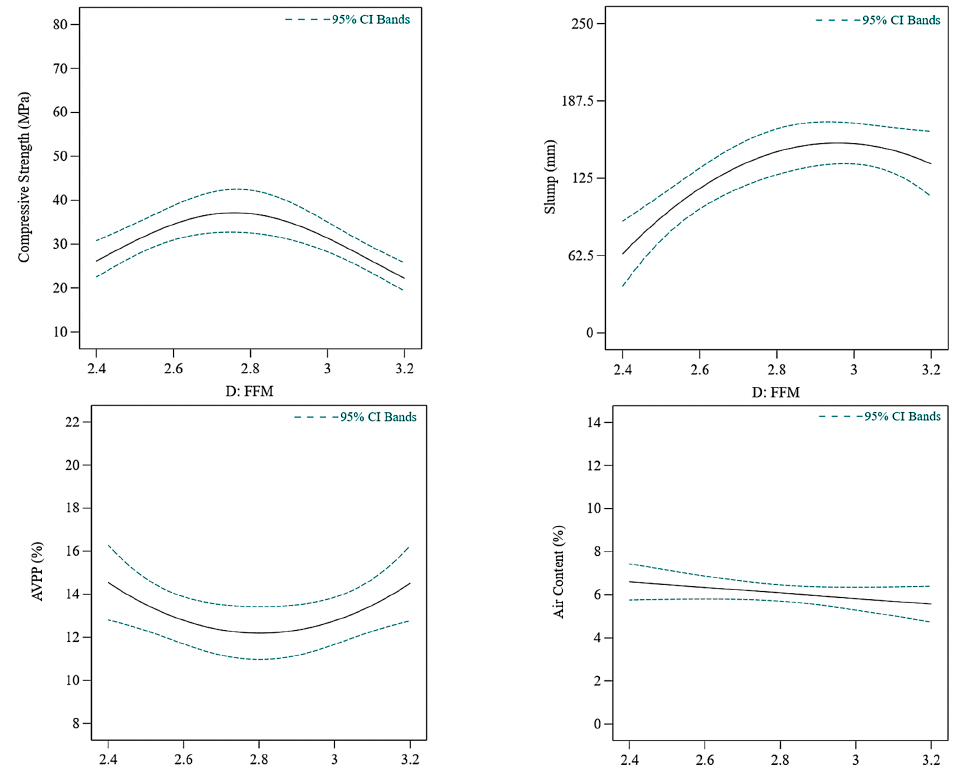
Figure 9. Effect of FFM on compressive strength, slump, AVPP, and air